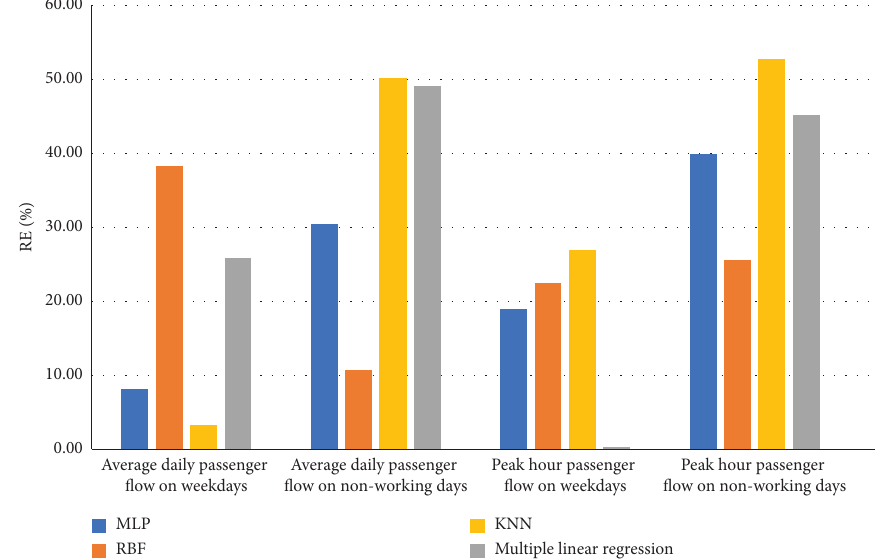
Figure 18: Comparison of prediction results for Xuanwumen